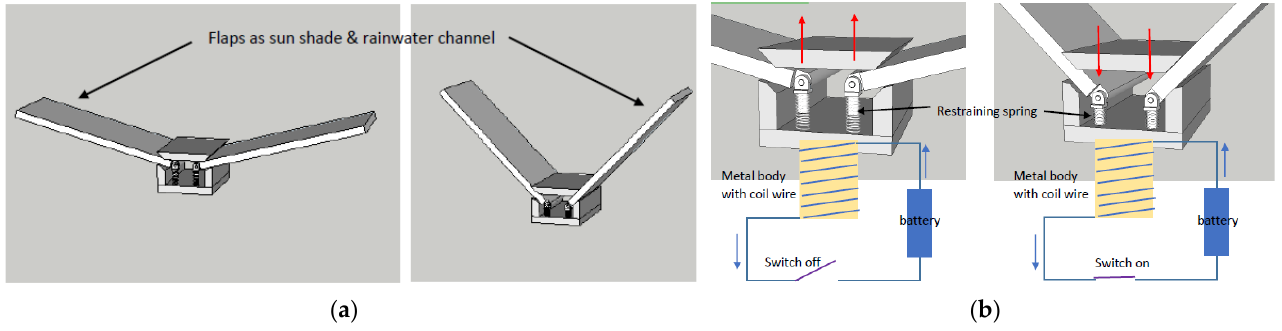
Figure 10. ( a ) Opening and closing of the shading device. ( b ) Electromagnetic circuit controlling the movement of the shading device [31].